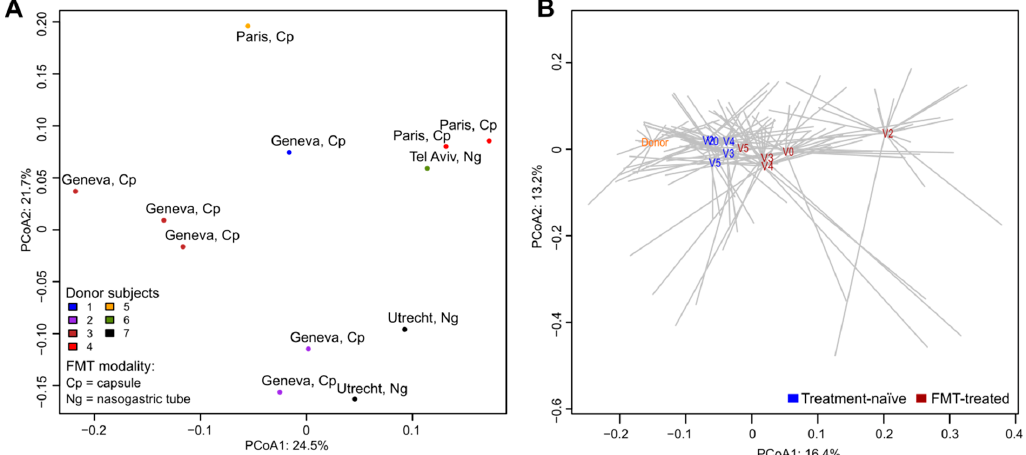
Figure 1. Global differences between microbial communities of fecal samples assessed by principal coordinates analysis (PCoA). The analyses were based on the relative abundance of bacterial species. The percentage of total data variance is reported for PCoA1 and PCoA2. ( A ) Samples from different donors. Data points are color-coded according to the donor. Each sample label reports the center of transplantation and the modality of FMT administration. ( B ) Comparison of samples from donors and FMT-treated and treatment-naïve carriers. Centroids (averaged microbiota profiles) of donors (orange) and of each sampling point (V0, V2, V3, V4 and V5) of treatment-naïve (blue) and FMT-treated (dark red) carriers are represented.